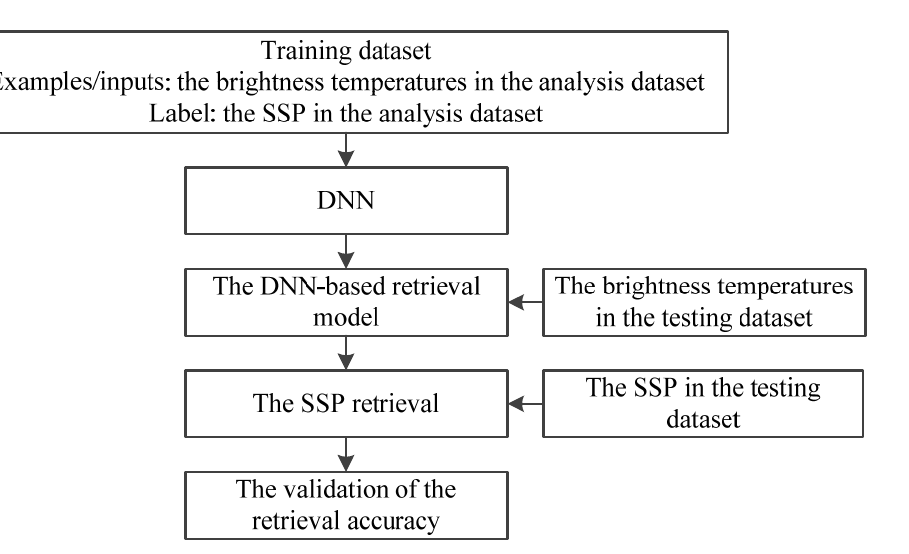
Figure 7. The schematic of retrieving